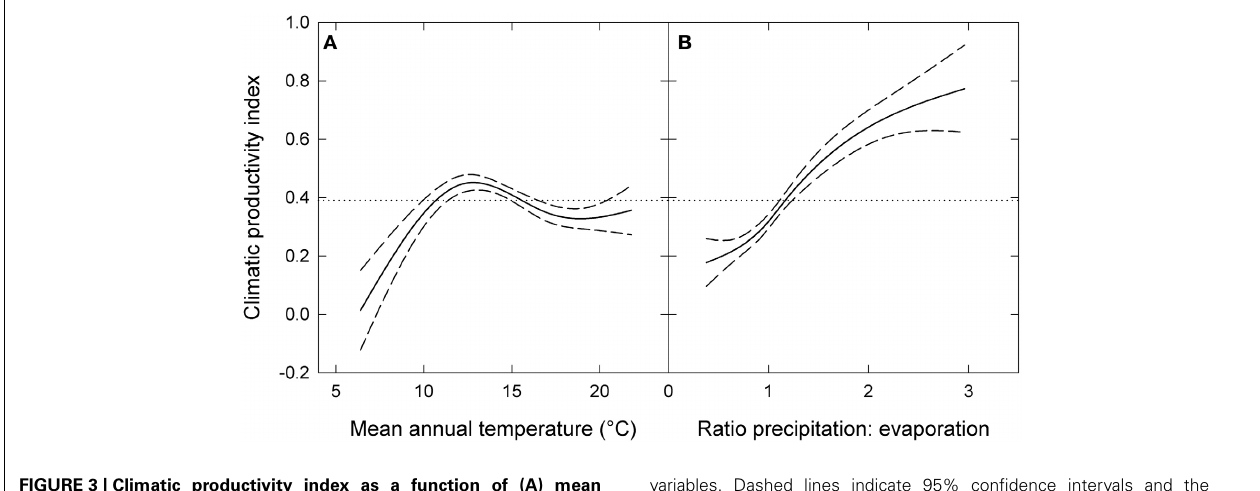
variables. Dashed lines indicate 95% confidence intervals and the dotted lines show mean growth rate for the entire dataset. Responses to each variable were calculated by holding the other variable constant at its mean value.